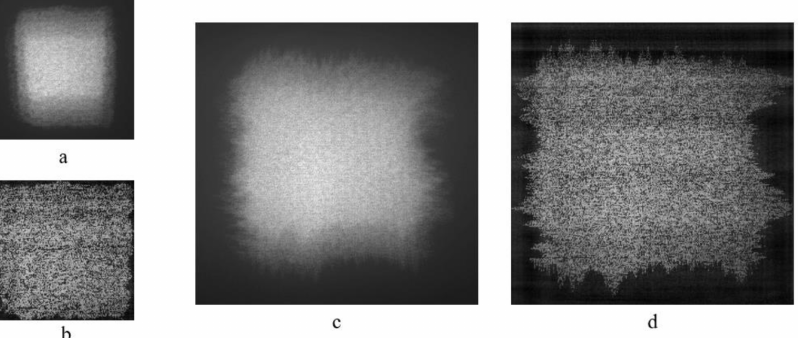
Figure 10. Encrypted ( a , c ) and decrypted images ( b , d ) corresponding to MCDDC with 128 × 128 ( a , b ) and 254 × 254 ( c , d )